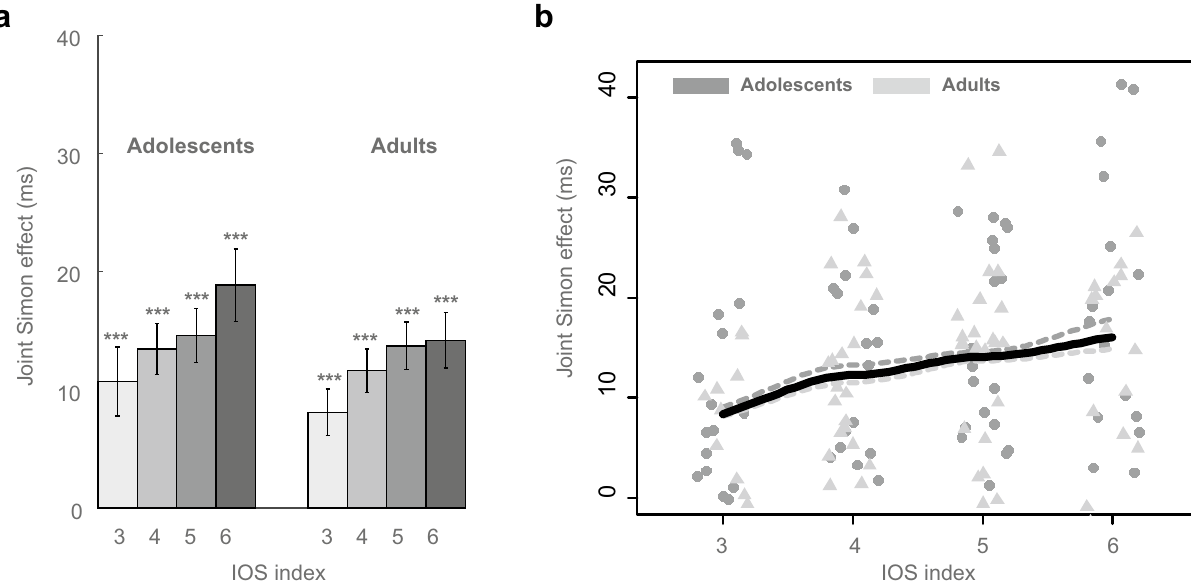
Figure 4. Congruency effects, measured as the RT in incongruent trials minus the RT in congruent trials, for the joint task (JNT) for the two age groups across the IOS scale. ( a ) Mean joint Simon effect for different IOS indices and the two age groups. Error bars indicate standard errors of the means. ** p < 0.01, *** p < 0.001 (paired t test, two-tailed). ( b ) Scatter plots of data across IOS indices for adolescents (solid circle) and adults (solid triangle) along with the smoothed lines using the locally weighted smoothing (loess) regression for adolescents (the dashed dark grey line), adults (the dashed light grey line), and both groups together (the solid black